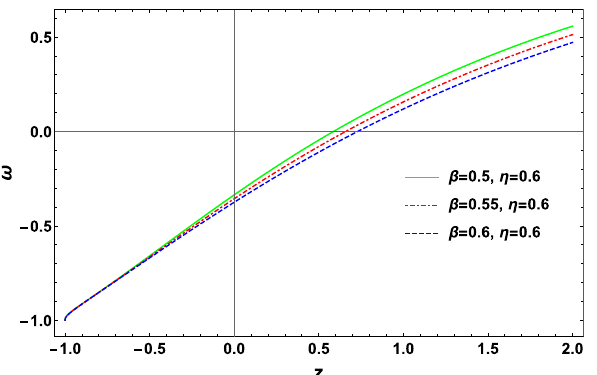
Fig. 8 Variation of energy density against time with k = 1, γ = − 2, λ = 35 3.3 The f ( R , T ) = R + me − nR + λ T